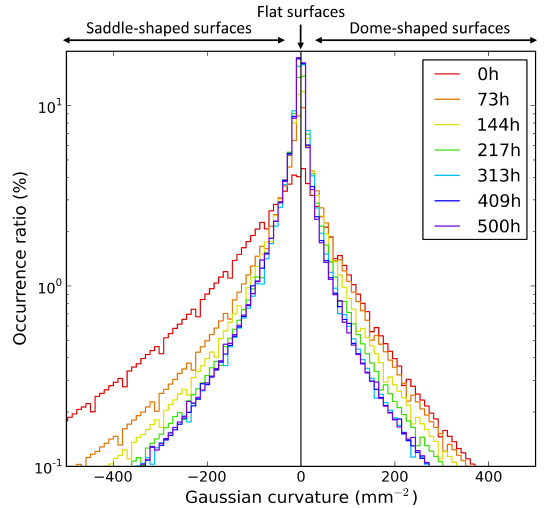
Figure 9. Time evolution of the Gaussian curvature distribution computed from the whole surface of the 3-D images. Each curvature class is 10mm − 2